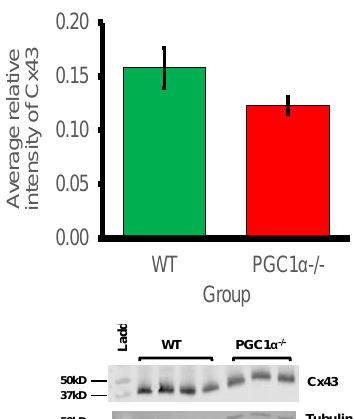
Figure 2. Western blot analysis of atrial Na v 1.5, Cx40 and Cx43 expression: 3 WT and 4 Pgc-1 α − / − atria were used. Representative blots are shown and the housekeeping protein β -tubulin used as a loading control. The primary antibodies used included monoclonal rabbit anti-Na v 1.5 (1:500); polyclonal goat anti-Cx40 (1:500); polyclonal rabbit anti-Cx43 (1:1000) and polyclonal goat anti- β -tubulin (1:1000). The secondary antibodies included donkey anti-goat IgG antibody in blots for Cx40 and β -tubulin (1:15,000), and donkey anti-rabbit IgG antibody in blots for Na v 1.5 and Cx43 (1:10,000).